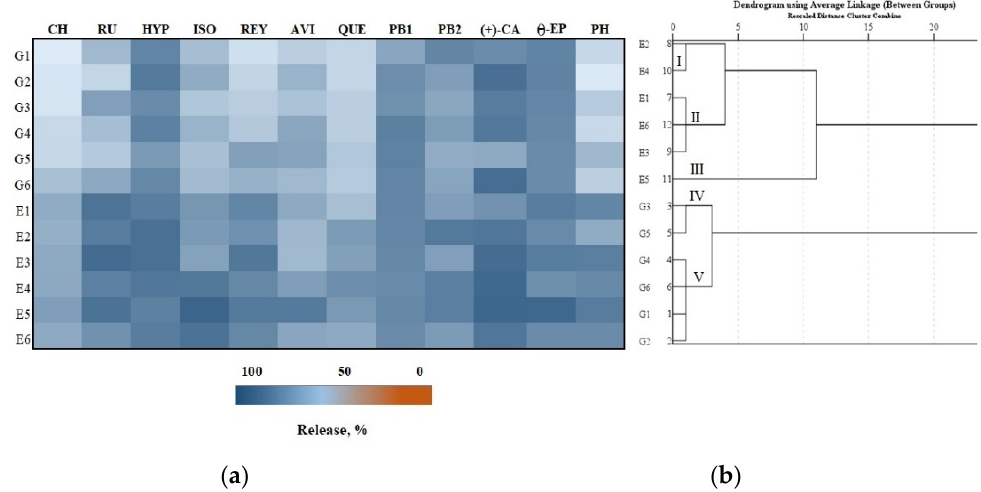
Figure 5. In vitro release test results: ( a ) Heatmap shows the percentage release of individual phenolic compounds from experimental gels (G1–G6) and emulgels (E1–E6) after 6 h; ( b ) the dendrogram illustrates variation in the total amount of phenolic compounds released from the experimental formulations after 6 h.